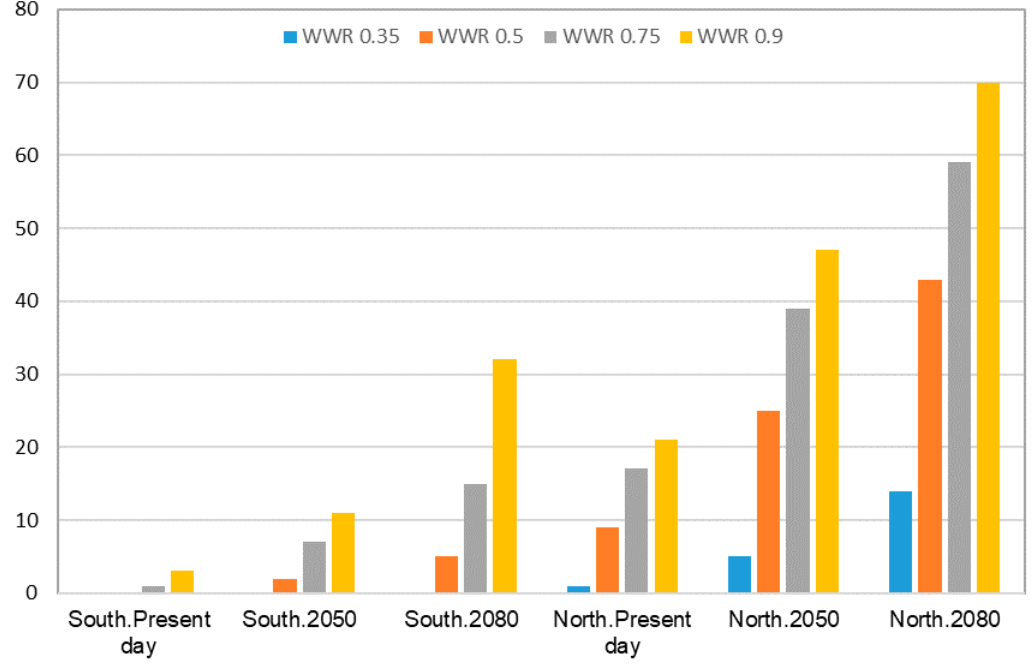
Figure 10. Hours of temperature exceeding 26 °C during the occupied period based on CIBSE TM 59 (Tight building).